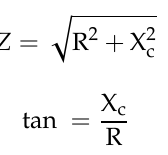
Figure 2. The relation of R, Xc , and Z.